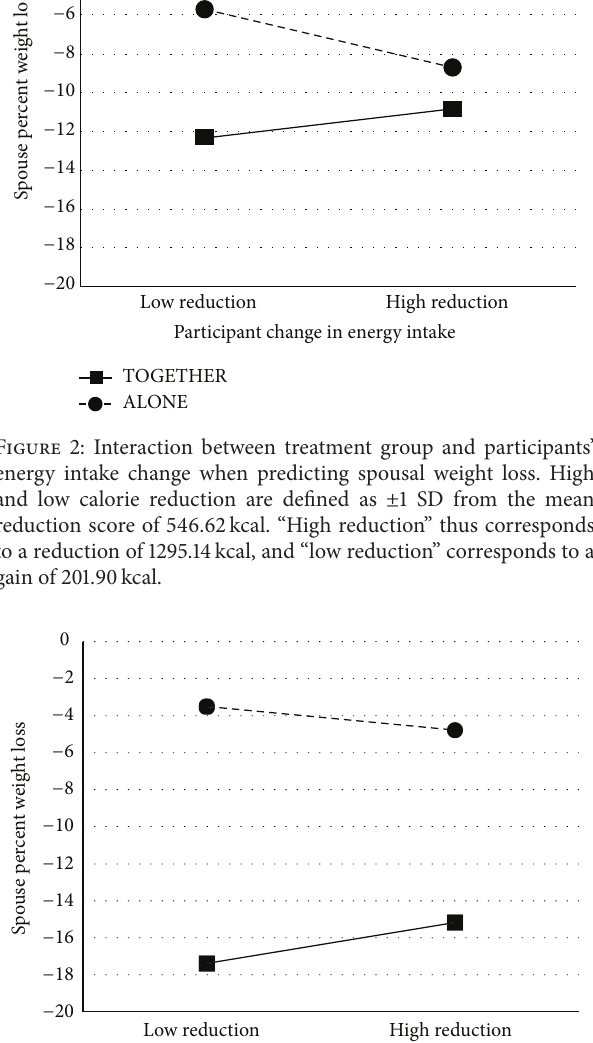
APIM. Similar to the energy intake results, our two primary research questions pertaining to the separate influences of the participant’s and spouse’s fat intake changes on the partici- pant’s weight loss did not emerge as significant. Baseline fat intake emerged as a significant covariate, 𝛽 = .24 , 𝑝 = .028 . Specifically, higher fat intake at baseline was associated with lower percent weight loss over six